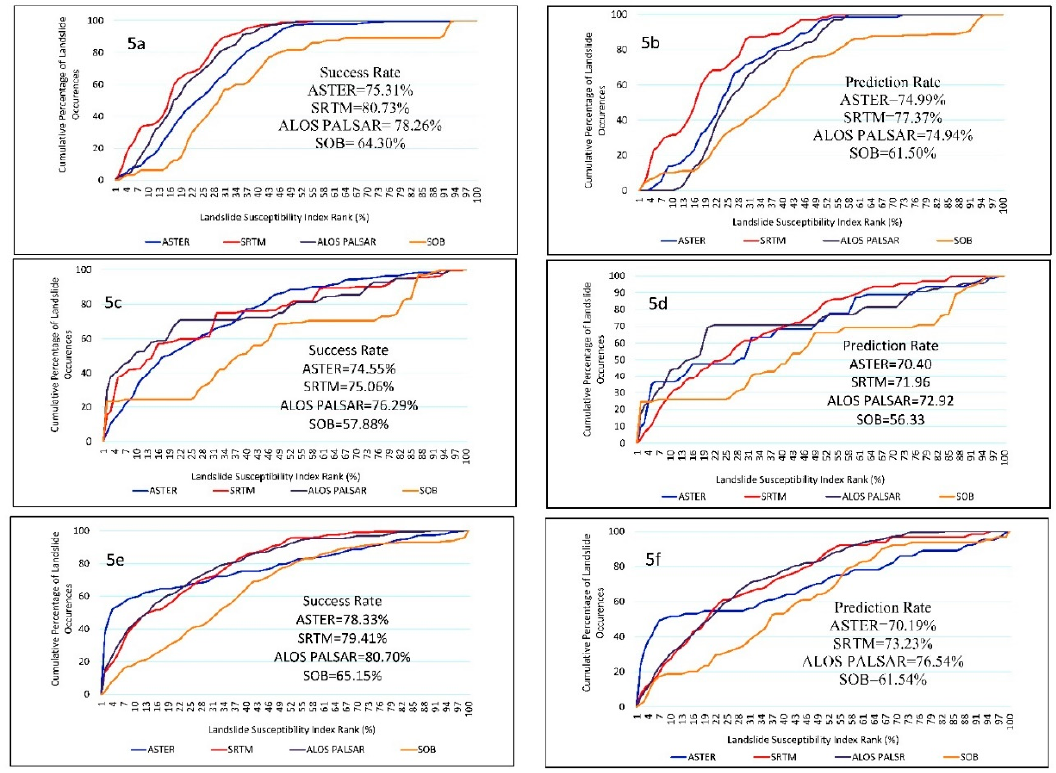
Figure 5. Success and prediction rate curves (seven DEM-based factors): ( a ) MFR (success); ( b ) MFR (prediction); ( c ) LR (success); ( d ) LR (prediction); ( e ) RF (success); ( f ) RF (prediction).